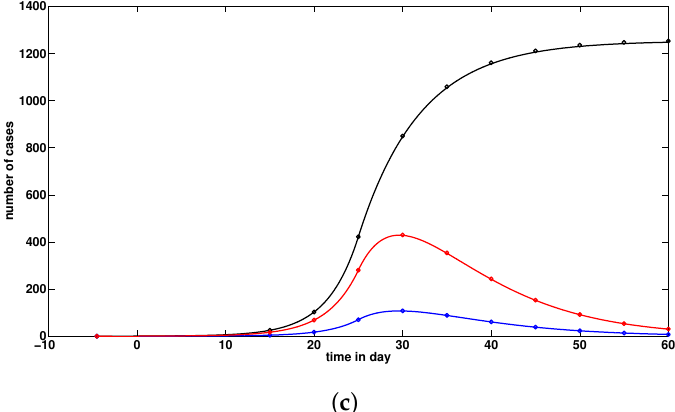
Figure 4. In this figure, we plot the graphs of t → CR ( t ) (black solid line), t → U ( t ) (blue solid line) and t → R ( t ) (red solid line). We use again f = 0.8, η = 1/7, ν = 1/7, and S 0 = 11.081 × 10 6 . In ( a ), we use χ 1 = 0.16, χ 2 = 0.38, χ 3 = 1.1, t 0 = 5.12 for the parameter values for China which give τ = 4.44 × 10 − 08 for t ∈ [ t 0 ,25 ] and τ = 0 for t > 25, I 0 = 3.62, U 0 = 0.2. In ( b ), we use χ 1 = 0.23, χ 2 = 0.34, χ 3 = 0.1 and t 0 = − 2.45, for the parameter values obtained from the data for Hubei province, which give τ = 4.11 × 10 − 08 for t ∈ [ t 0 ,25 ] and τ = 0 for t > 25, I 0 = 0.3, U 0 = 0.02. In ( c ), we use χ 1 = 0.36, χ 2 = 0.28, χ 3 = 0.1, and t 0 = − 4.52 for the parameter values obtained from the